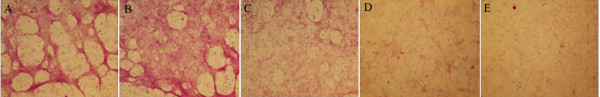
The effect of Genistein on the vasculogenic mimicry of human uveal melanoma C918 cells on 3-D collagen I cultures. PAS-stained images of C918 cells cultured on three-dimensional collagen I for 48 h in medium with different concentrations of Genistein. (A) control; (B) 25 μM Genistein; (C) 50 μM Genistein; (D) 100 μM Genistein; (E) 200 μM Genistein. At treatment groups with 25 μM and 50 μM concentrations of Genistein, C918 cells formed fewer VM matrix-association channels than do control. However, the groups treated with higher concentrations of Genistein (100 and 200 μM) did not form the VM channels. (Magnification: × 200)